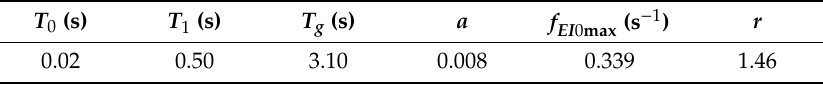
Table 5. Parameters for fitted elastic seismic-induced input energy